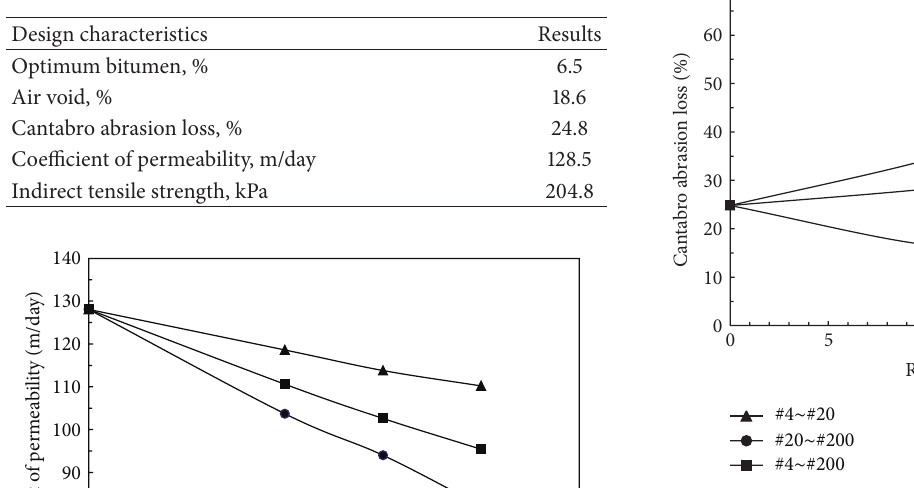
Table 4: Result of the Porous Asphalt Mix Design.